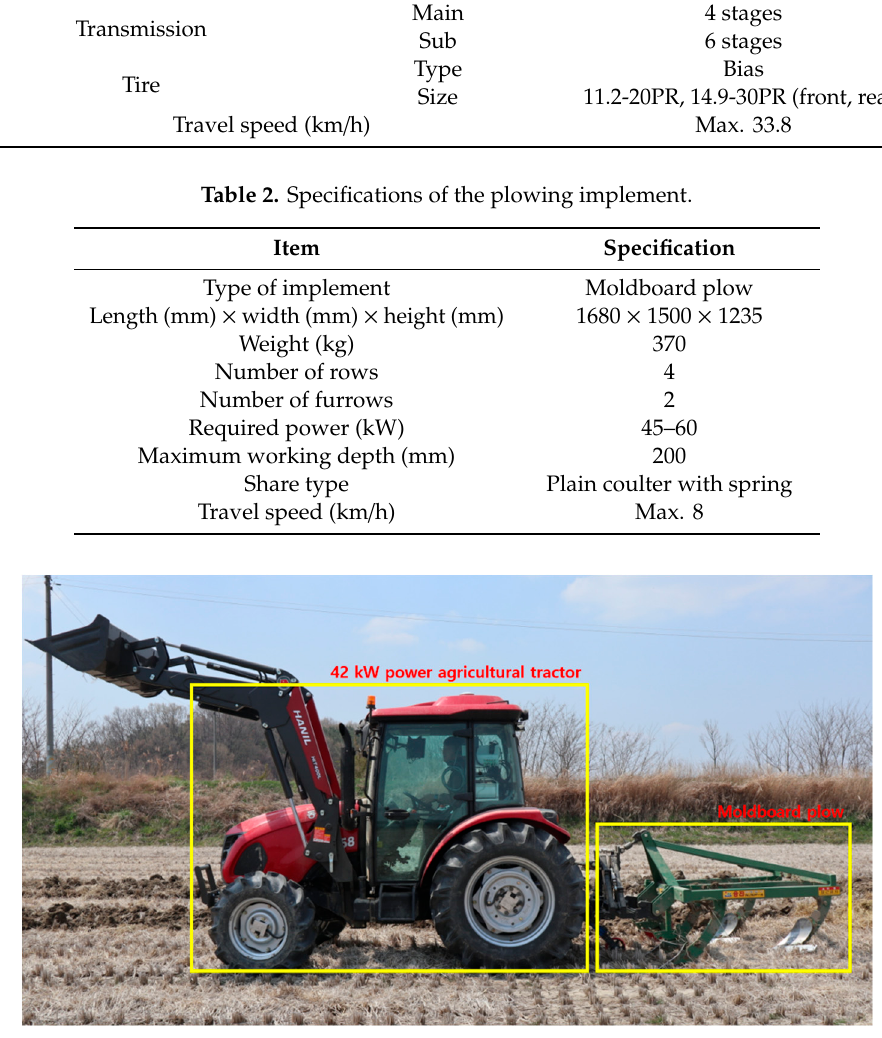
Figure 1. Tractor-implement system used for field experiment in this study.